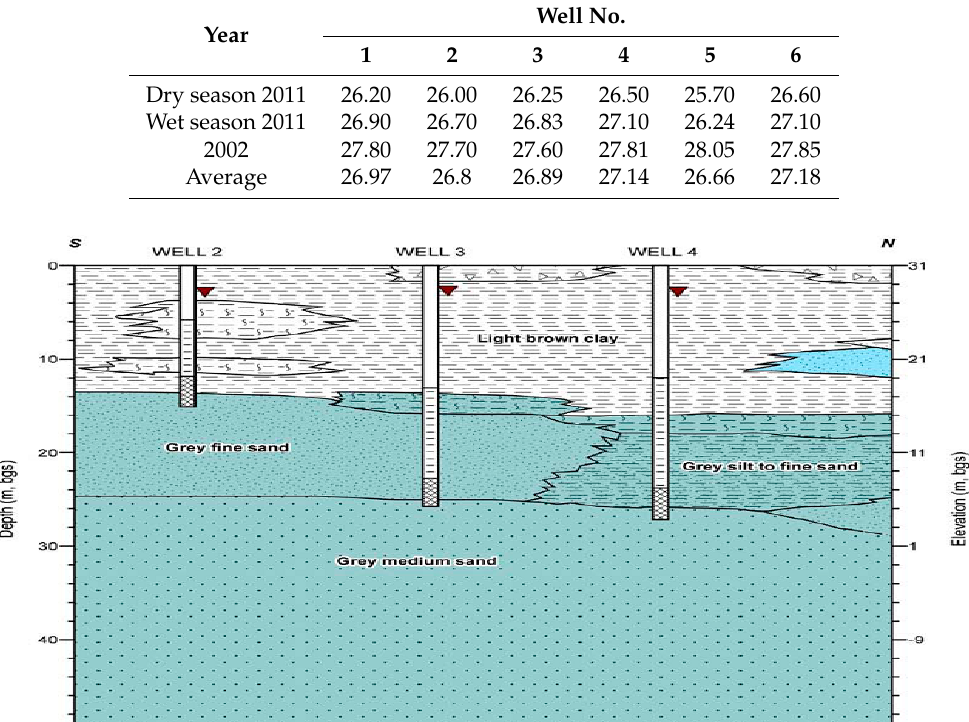
Table 1. Variation of groundwater level for wells, m.a.s.l. (2002 and 2011). Well No. Year